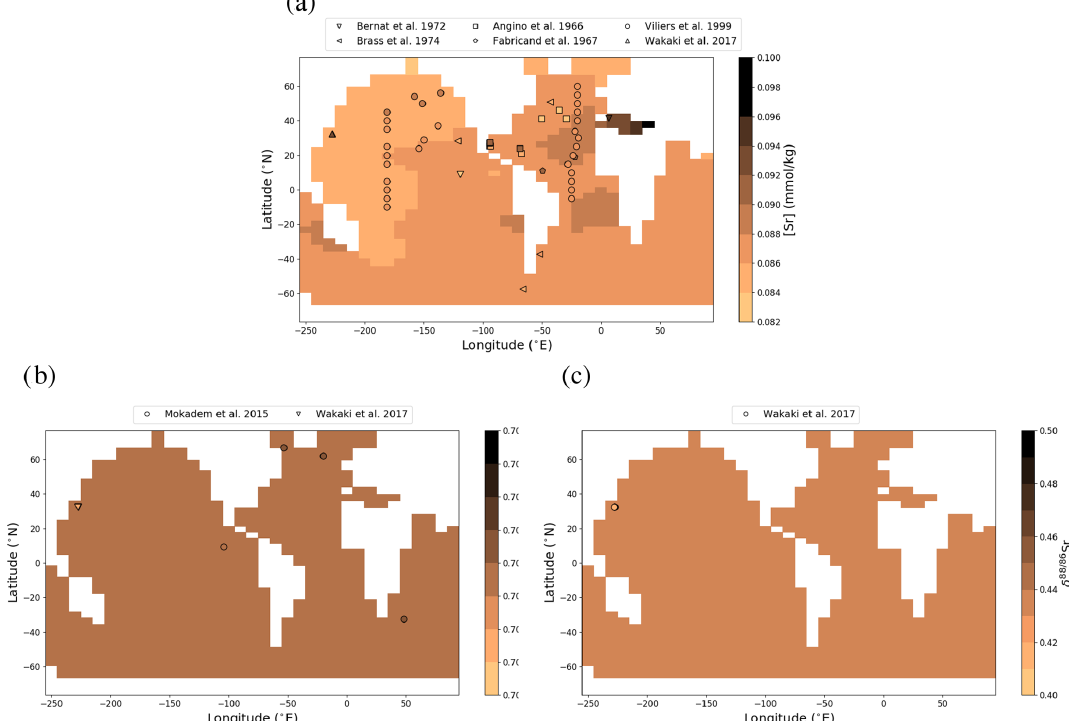
Figure G1. Comparison between measured and simulated Sr concentrations (a) and isotopic composition (b, c) in surface waters. Measure- ments are shown as symbols on the map, with the color indicating the respective value. Data are taken from Angino et al. (1966), Fabricand et al. (1967), Bernat et al. (1972), Brass and Turekian (1974), De Villiers (1999), Mokadem et al. (2015), and Wakaki et al.